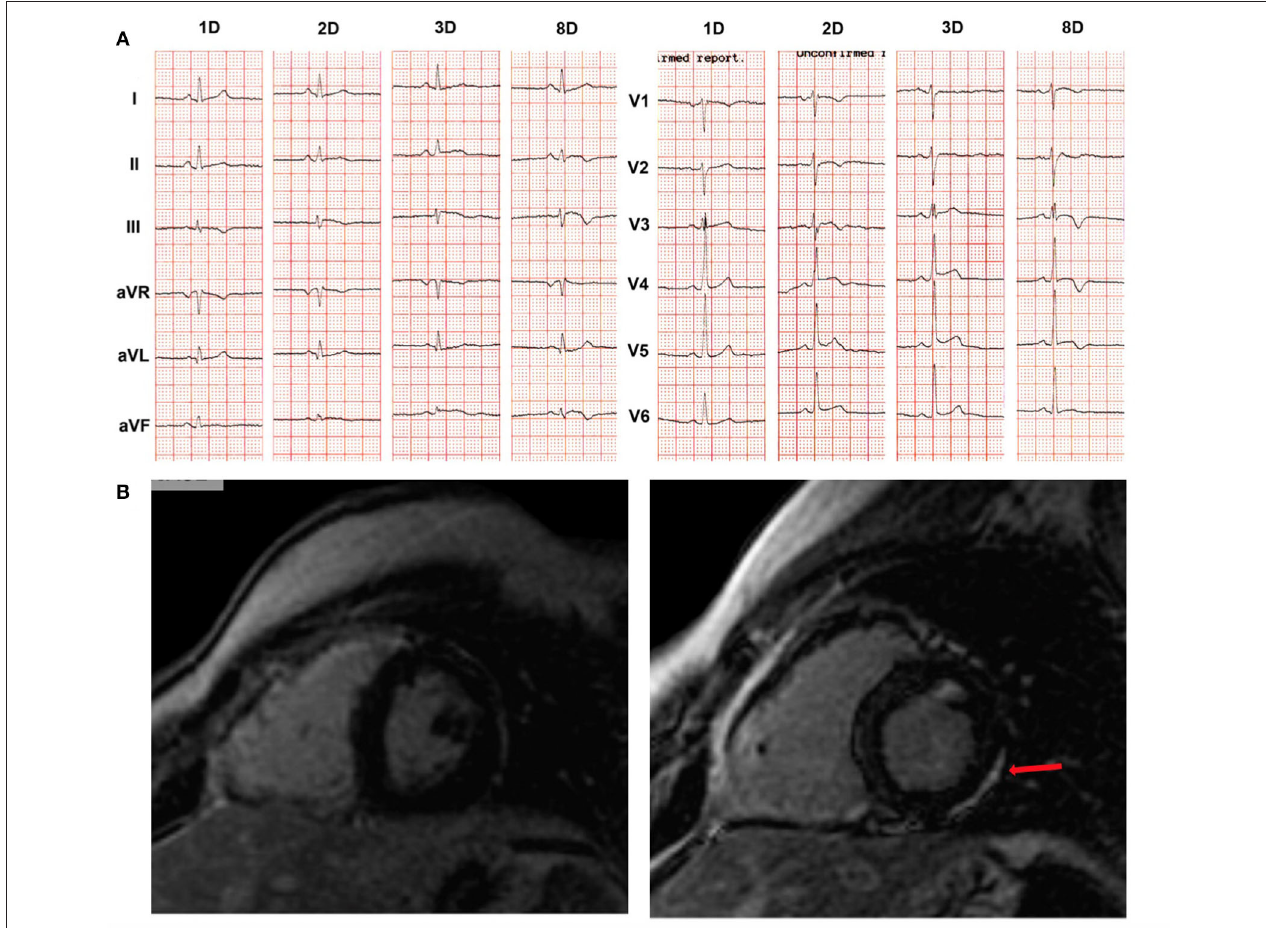
FIGURE 7 | Example of a boy with Naxos disease, homozygous for a pathogenic JUP variant, on regular follow-up since the age of 1 year old. He was asymptomatic until the age of 14 years when he was admitted with chest pain, increased troponin-I levels up to 20 µ g/L (normal values: 0.04 µ g/L), complex ventricular extrasystoles and changes on 12-lead ECG. (A) ECG recordings in 25 mm/s, 10 mm/mV, at the first (1D), second (2D), third (3D) and eighth (8D) days of hospitalization. Newly developed repolarization changes are observed. (B) Phase-sensitive inversion recovery CMR images to detect LGE 1 year prior to hospitalization ( left ) and the second day of hospitalization ( right ) are shown. No functional changes were observed on either CMR in both ventricles (i.e., normal LV and RV function). However, LGE was detected (arrow) in the LV myocardium (right ) as compared to the isolated involvement of RV free wall, a year previously (left) , suggesting progression of disease. CMR, cardiac magnetic resonance; ECG, electrocardiogram; LGE, late gadolinium enhancement; LV, left ventricular; RV, right ventricular. Source: (69), obtained with